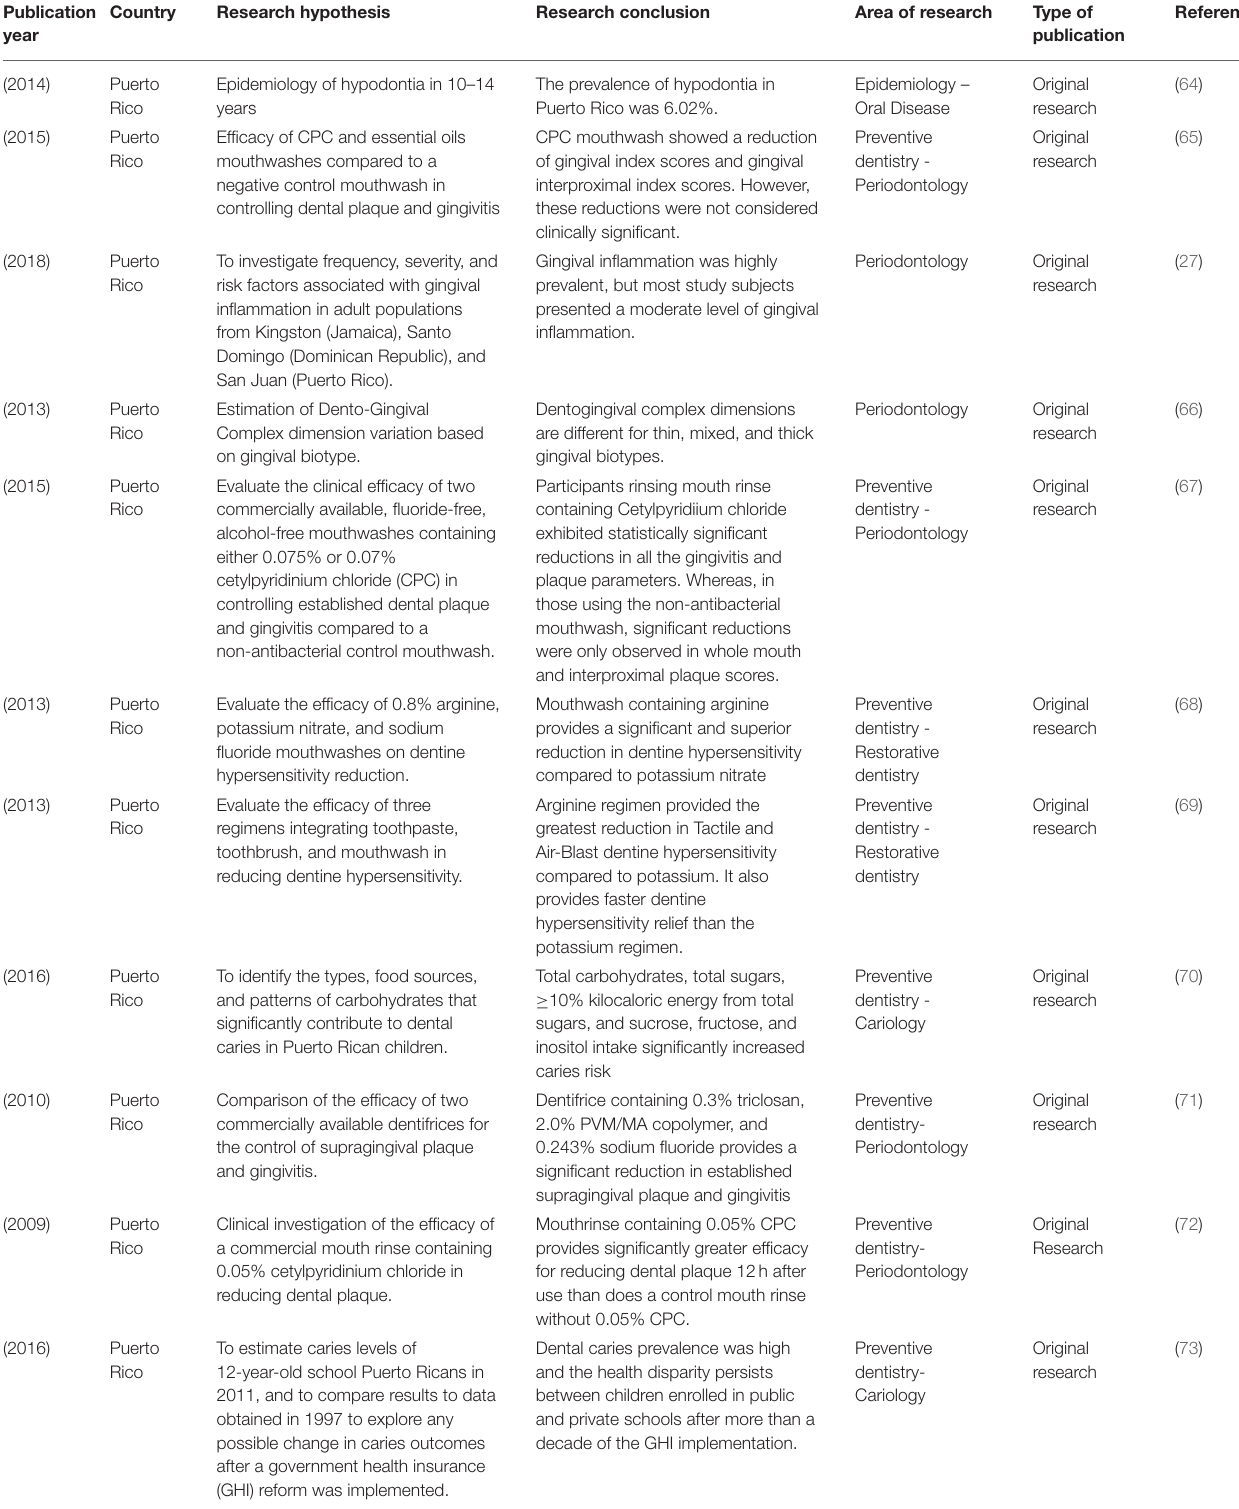
TABLE 1 | Published research findings from the Caribbean